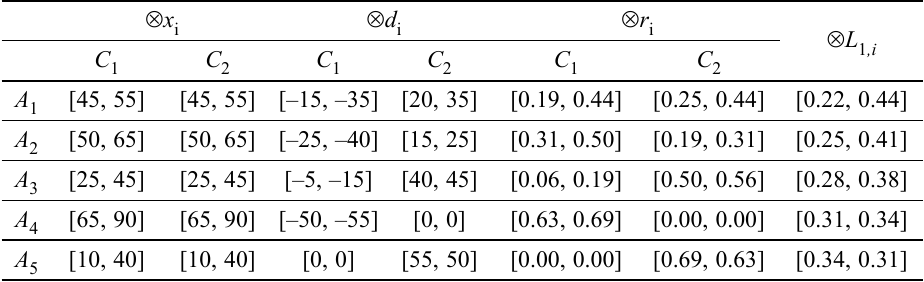
Table 16. The results of calculations in the case of grey ideal point